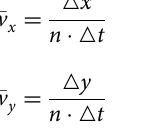
skyrmion velocities for a single-pulse current stimulation. Previous studies 11,12,27 predict a low depinning force ( j * C ) for a